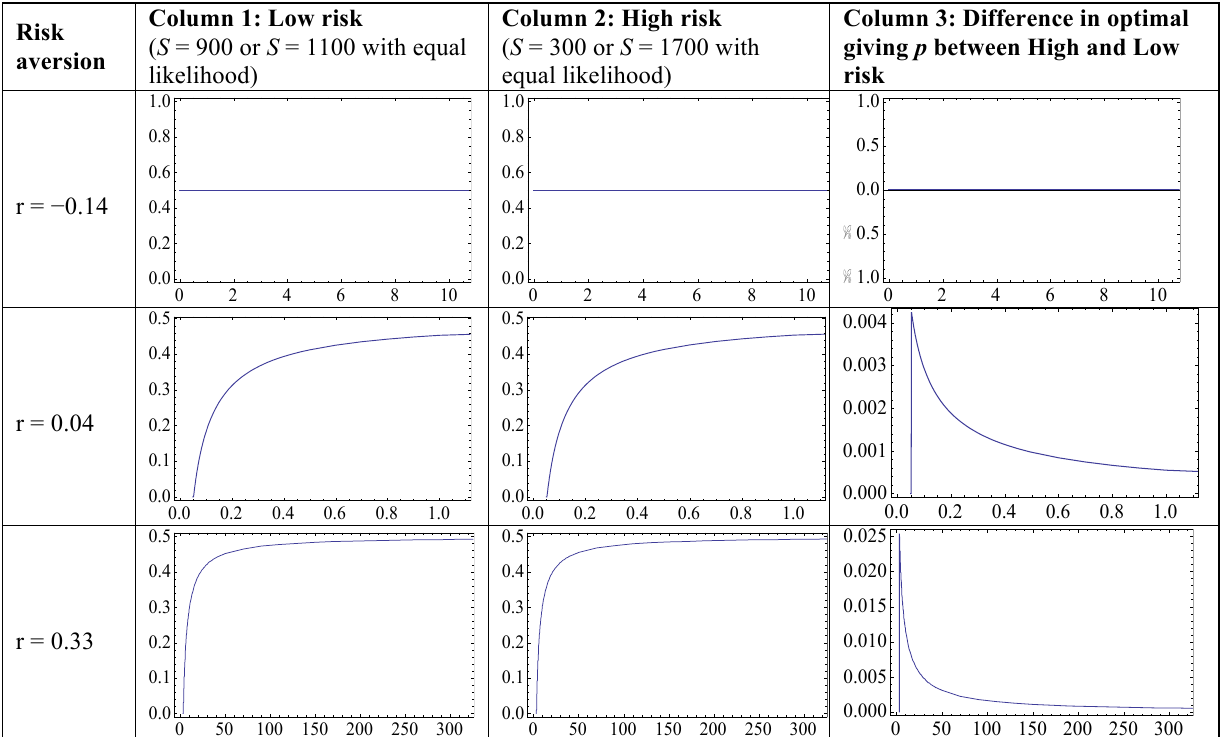
Figure A.2. Effect of risk on giving in the Dictator